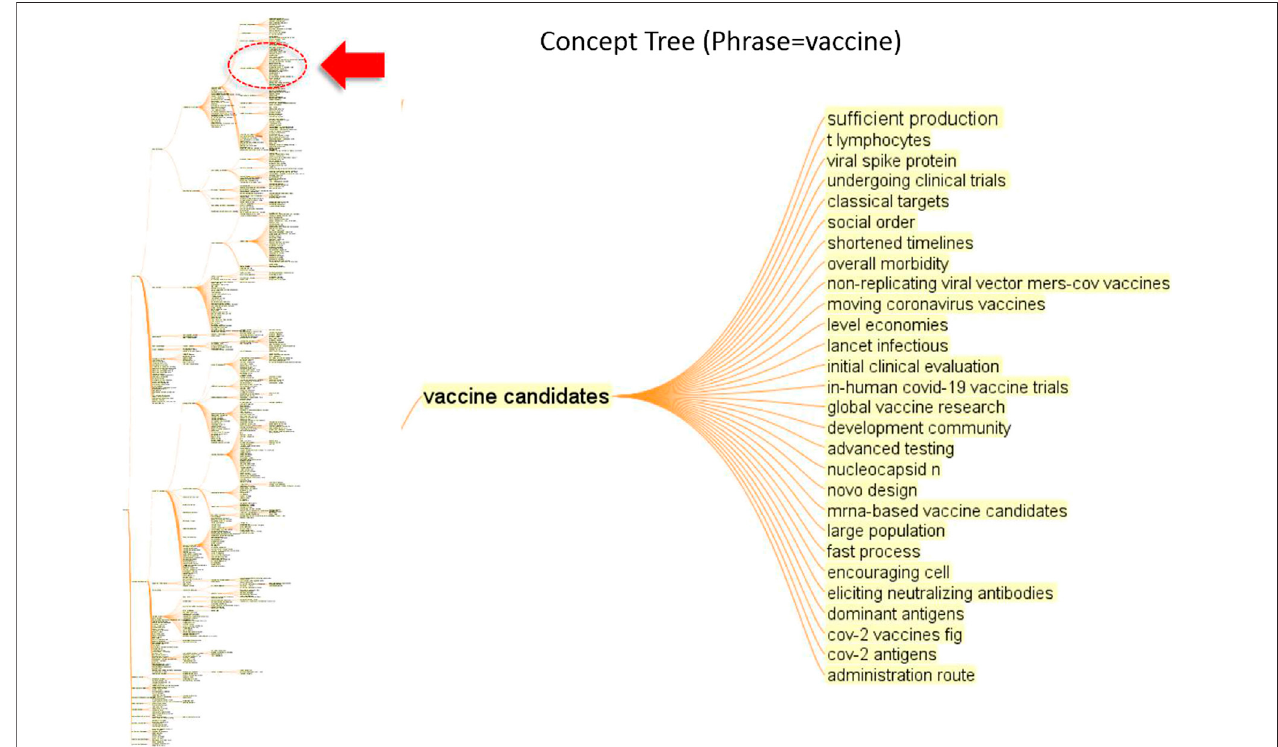
FIGURE 5 | Concept tree of a phrase: